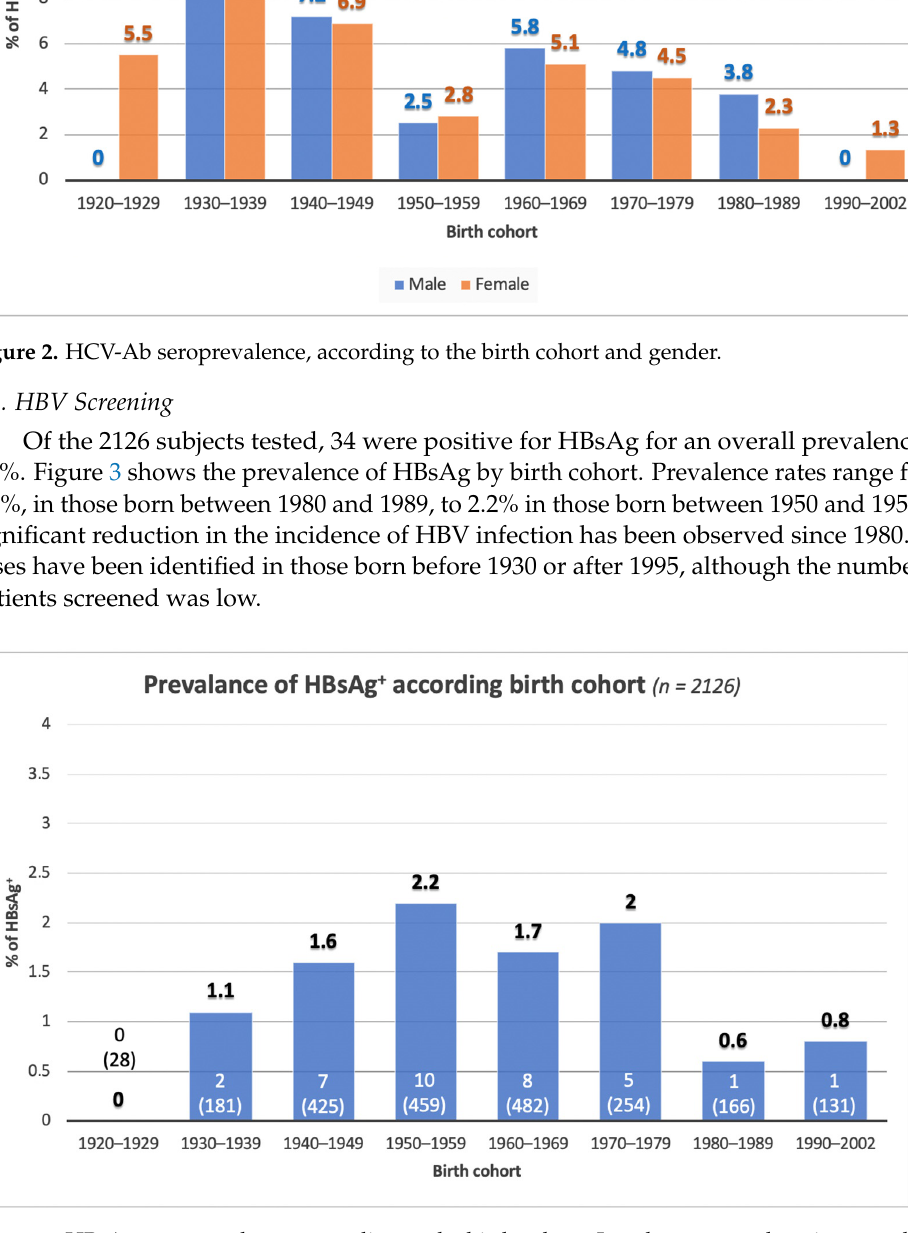
Figure 2. HCV-Ab seroprevalence, according to the birth cohort and gender.